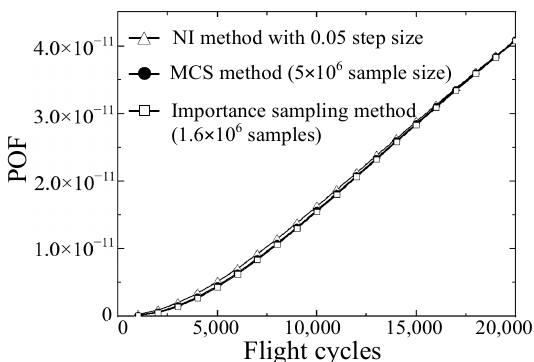
Figure 18. Comparison of the POFs of different methods.